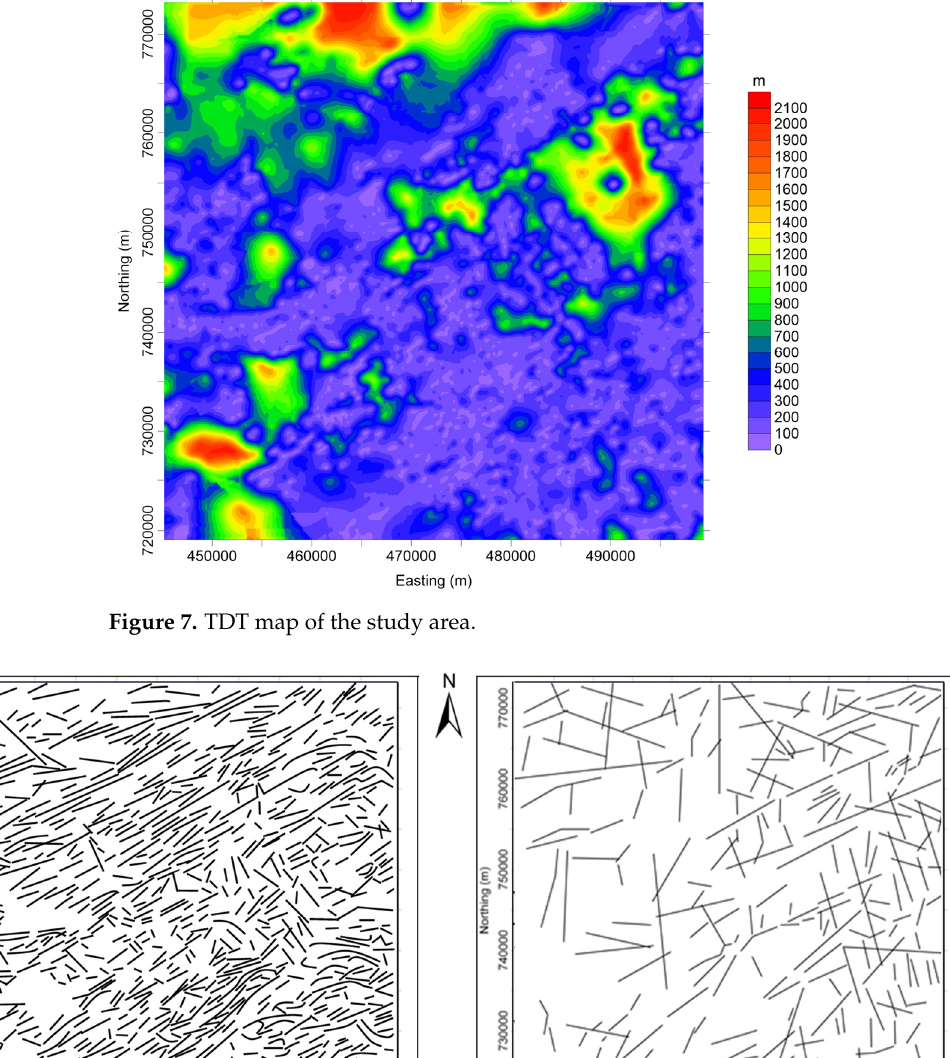
Figure 6. IL map of the study area.